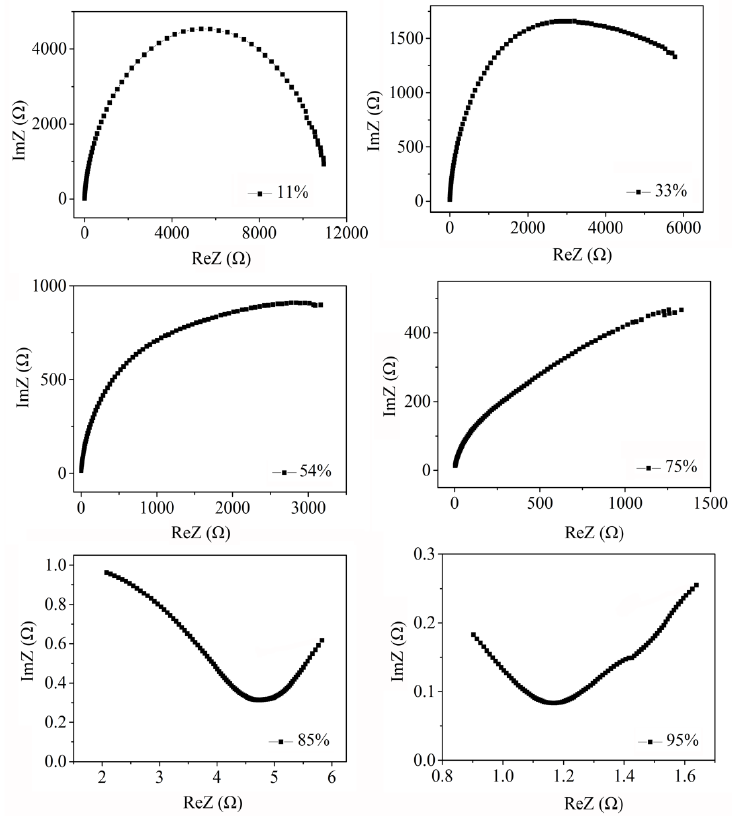
Figure 8. The complex impedance curve of ZnO/AuNPs (6 mL) humidity sensor measured at different